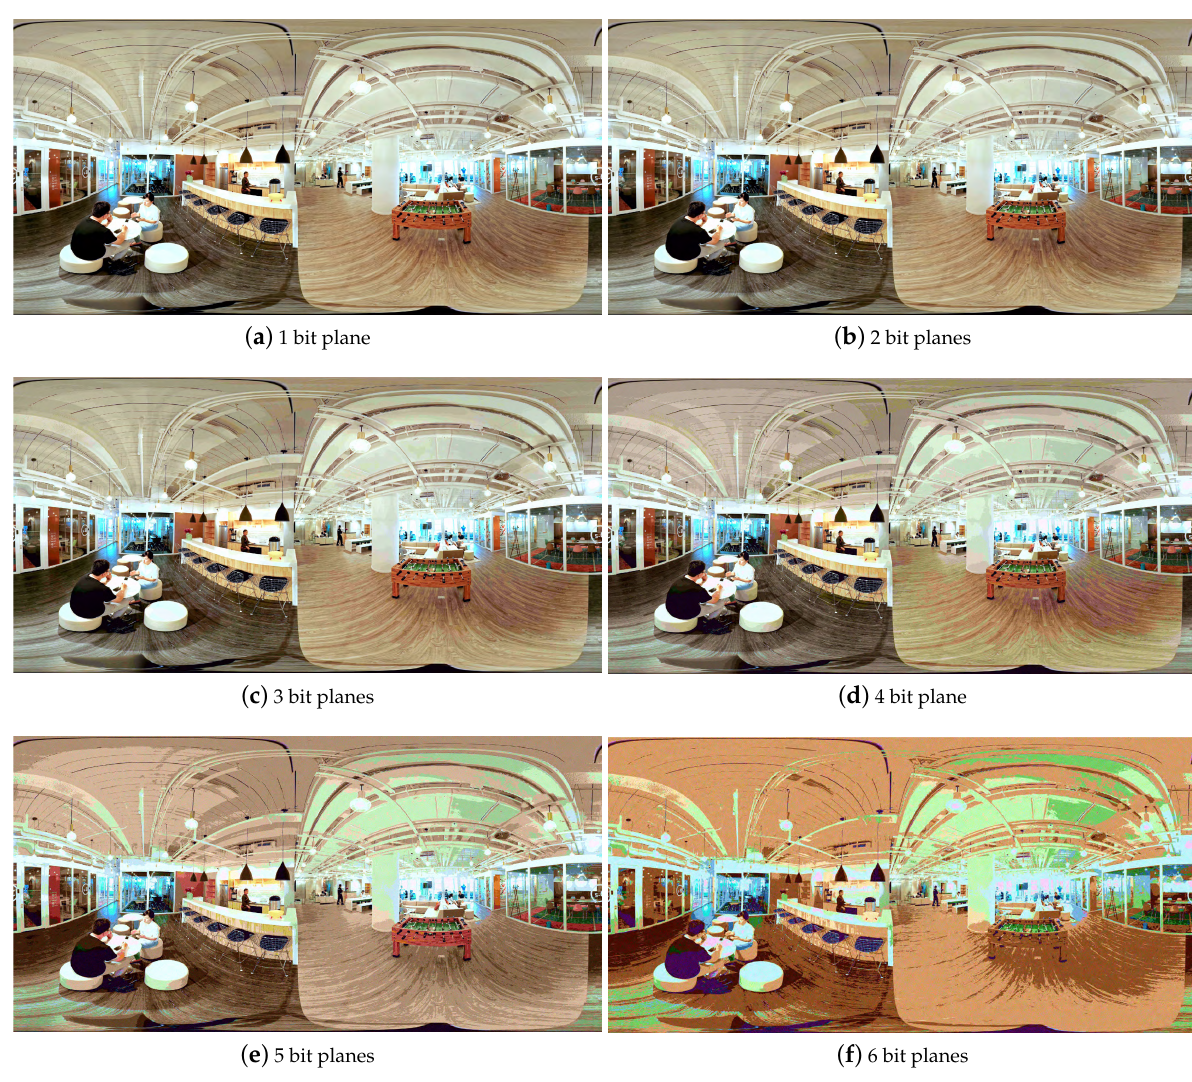
Figure 6. Sample 360 ◦ stego-video frames of scene “Salon” with viewing direction based LSB data hiding in the latitude and longitude for different numbers of bit